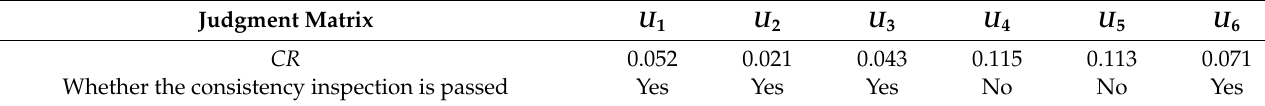
Table 2. Consistency calculation results of the judgment